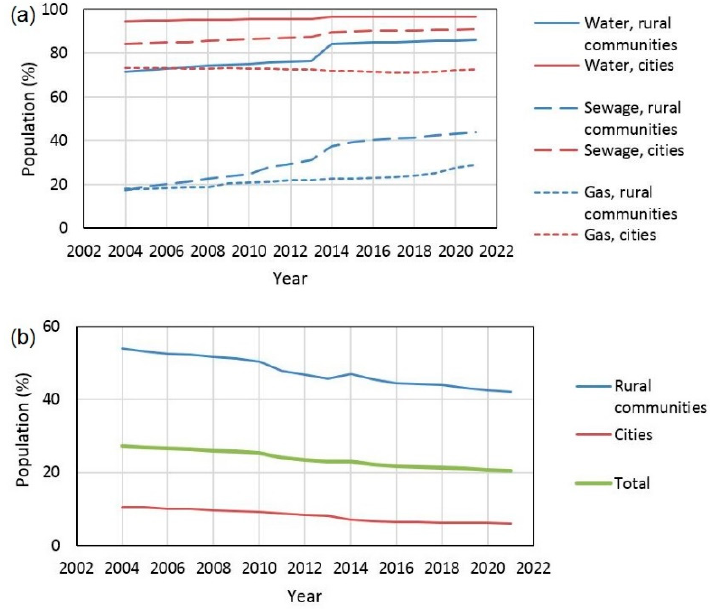
Figure 5. Accessibility of rural water, sewage and gas supply networks in Poland, data obtained from [66]: ( a ) rural and urban population connected to organized water, sewage and gas networks, ( b ) difference between population connected to water and sewage networks.